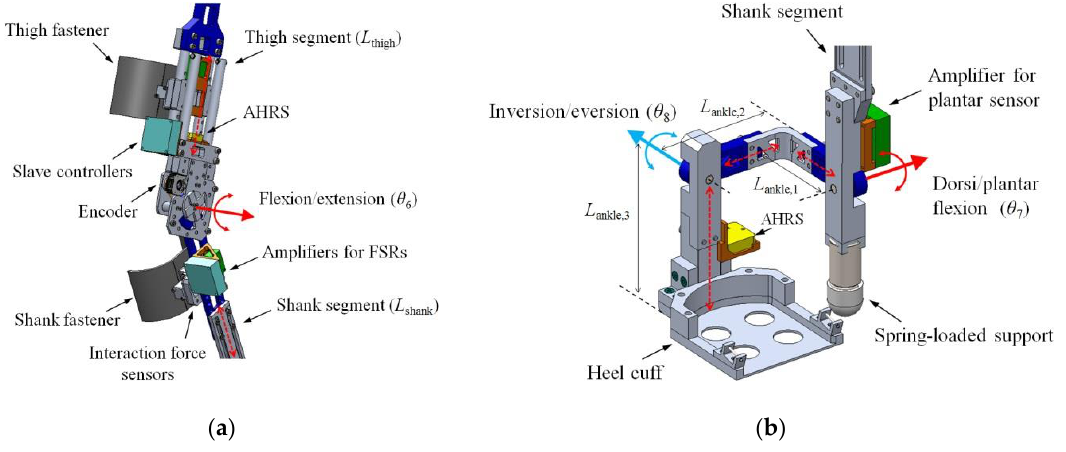
Figure 4. Configuration of ( a ) the joint for knee flexion/extension and ( b ) the joint for ankle dorsi/plantar flexion and